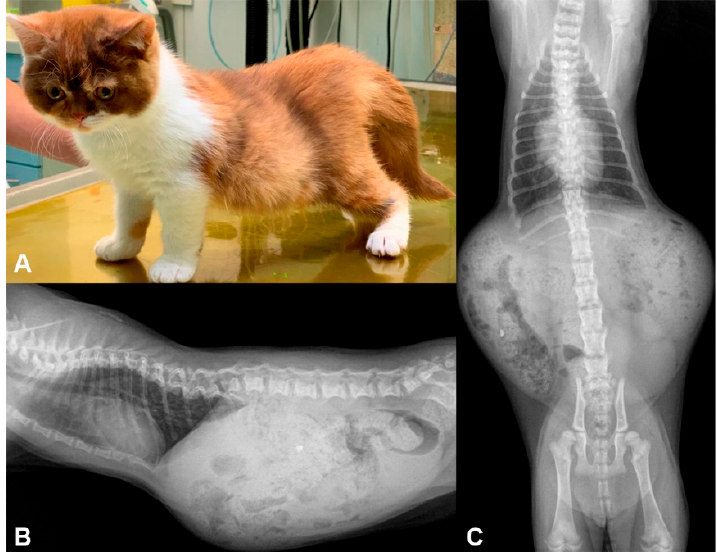
Figure 1. Clinical phenotype. ( A ) Photograph of the affected female kitten. ( B ) Radiograph in latero-lateral projection of the female kitten. ( C ) Radiograph in ventro-dorsal projection of the female kitten. Note the lordosis of this kitten, the malformation of the vertebral column within the thoracic region and the enlarged abdomen due to coprostasis.